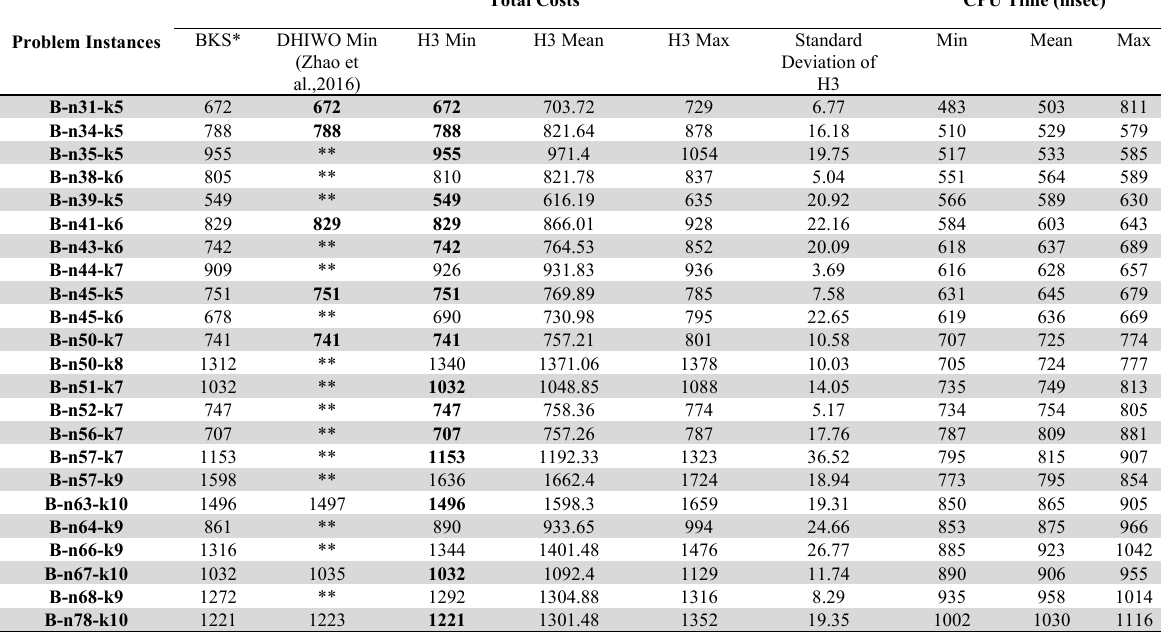
Comparison of the results with previous works for problem instances B Problem